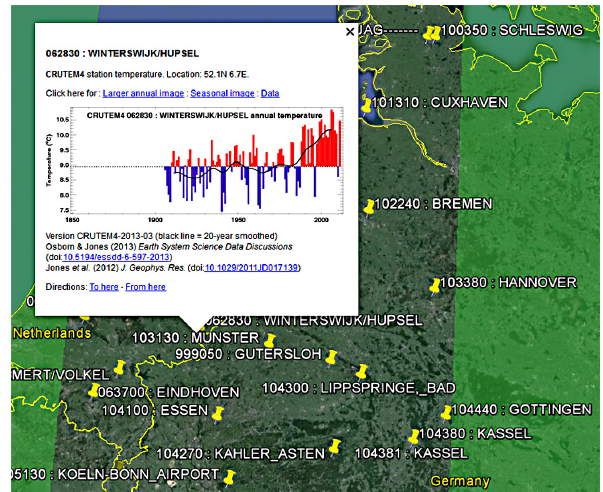
Figure 5. Image from Google Earth showing the box that appears after clicking on one of the weather station marker pins. The box shows the annual-mean temperature time series as bars (blue for values below a reference mean, red for values above; the reference mean is from the 1961–1990 period if there are at least 18 annual values within that period, otherwise it is the overall mean of the data) with a black line for the 20yr smoothed variations. The box also shows the location of the weather station, its CRUTEM4 iden- tifier (usually the WMO identifier) and name, and provides links to a larger image of the annual time series, to an image of the seasonal-mean temperature time series, and to a text file contain- ing the monthly, seasonal and annual temperature values for this weather